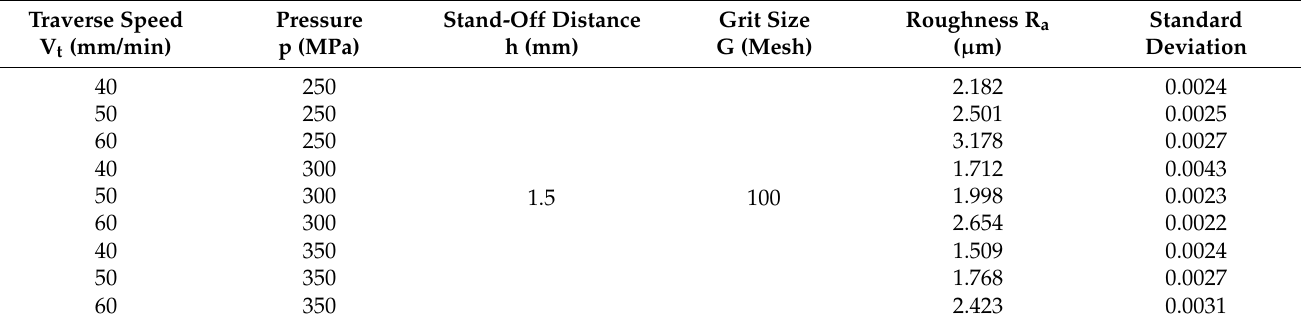
Table 2. Roughness values obtained upon adjusting traverse speed and water